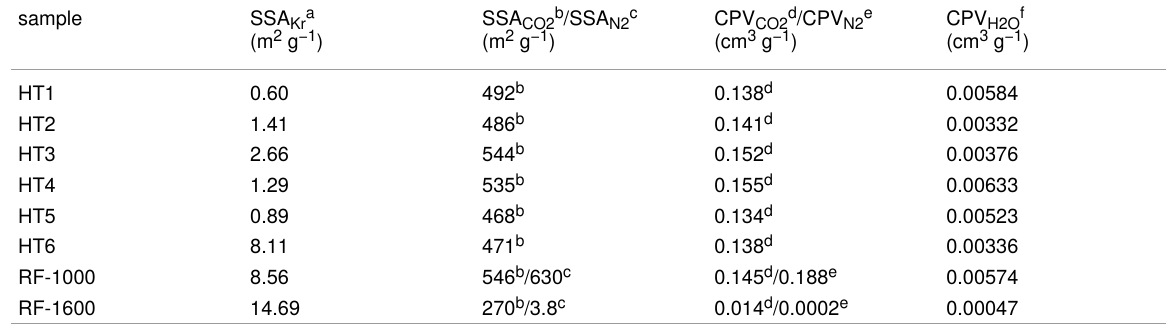
Table 1: Properties of the carbon samples from Kr, CO 2 and H 2 O sorption.